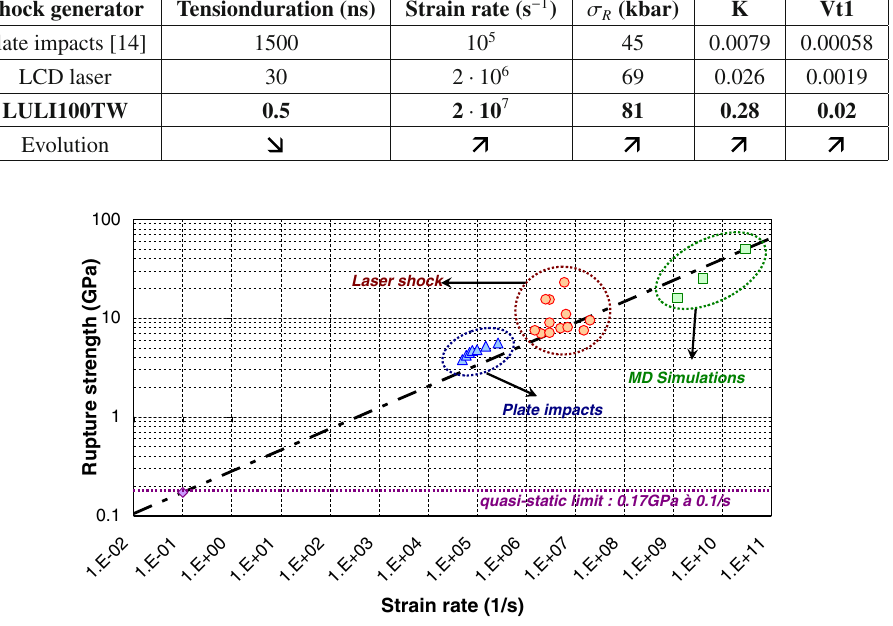
Fig. 4. Failure stress / strain rate diagram for tantalum obtained with plate impacts [14], laser driven shock and MD